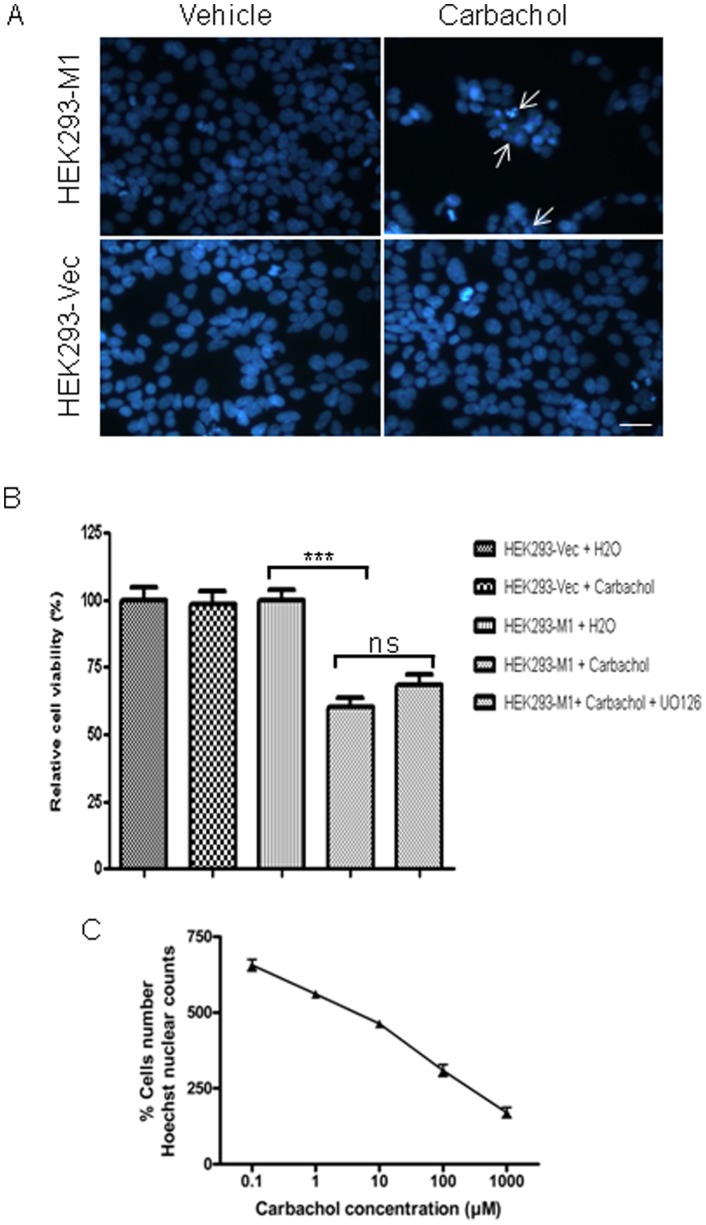
Chronic M1 mAChRs activation induces HEK293-M1 cell death.(A) Hoechst staining of HEK293-M1 and HEK293-Vec treated with water control (vehicle) or 100 µM carbachol for 24 h. The arrows point to condensed (possibly apoptotic) nuclei that were present in carbachol-treated HEK293-M1 cells. Note the substantial cell loss in the M1 expressing HEK cells, but not in the vector transfected HEK cells. Scale bar: 25 µm. (B) The extent of cell loss was investigated further using the MEK-inhibitor UO126. Hoechst stained cells were quantified using Discovery-1 and Metamorph analysis. Statistical significance: *** denotes p<0.001 compared with all other conditions. Note that UO126 did not significantly affect the carbachol response (ns) (C) HEK293-M1 cell counts across a range of 24 h carbachol treatments also showed that cell death occurred in a concentration-dependent manner. Data are representative of at least three independent experiments.